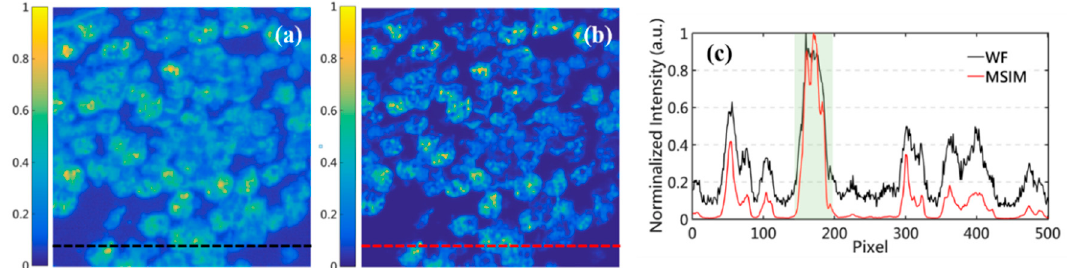
Figure 8. Results of the fixed partial transverse section of earthworm (dehydration structure of body cavity fluid) by WF microscopy ( a ) and MSIM ( b ). ( c ) Intensity profiles along the colored dash lines in ( a , b ), respectively. Scale bars: 40 μ m.